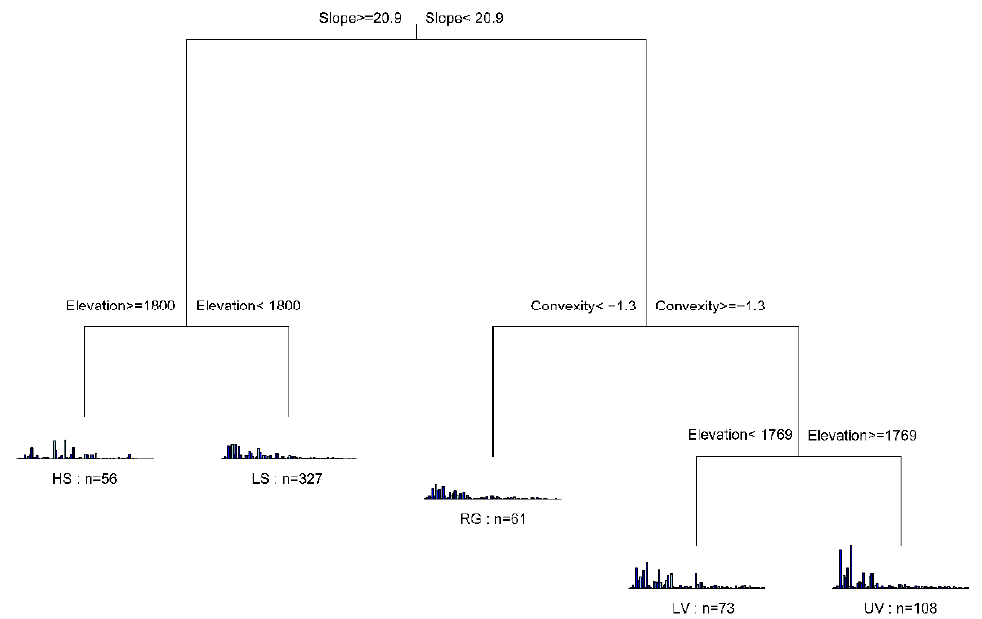
Figure 4. The result of multivariate regression trees of the 25-ha permanent forest dynamics plot in the Qinling Mountains, north-central China. The bar graphs show the species abundance in each habitat. HS: high-slope, LS: low-slope, RG: ridge, LV: low-valley, UV: upper-valley, n : number of quarts in each habitat.